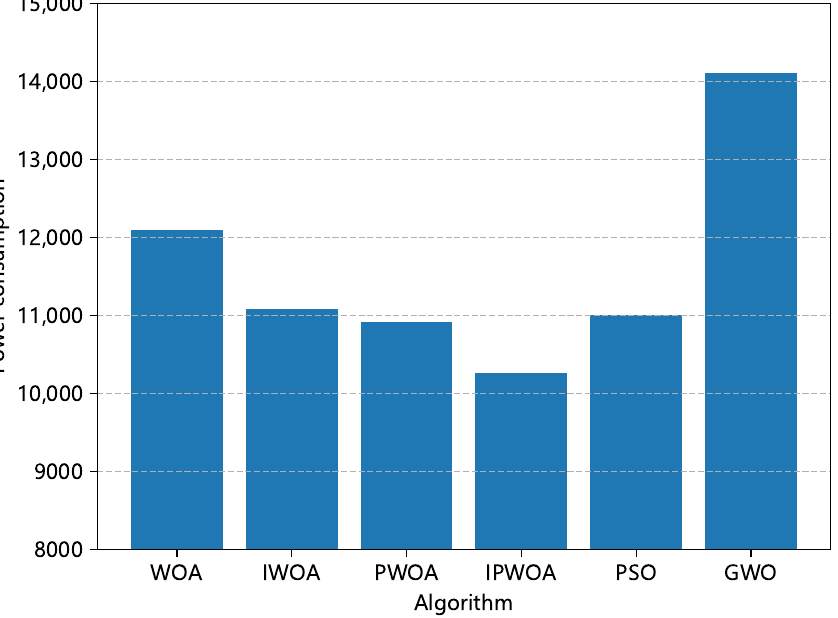
Figure 7. Comparison of the power consumption impact of different algorithms for edge comput- ing. The resource device power consumption was generated by the optimal allocation scheme of each